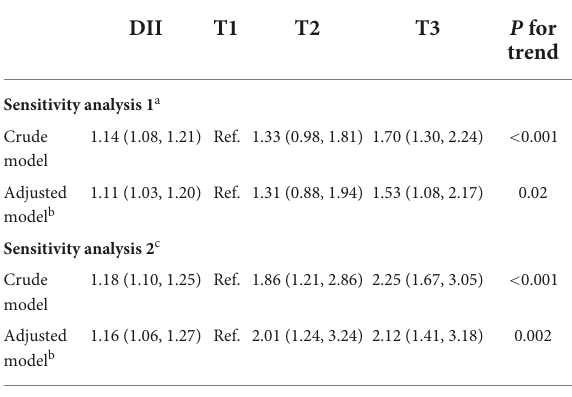
TABLE 3 Sensitivity